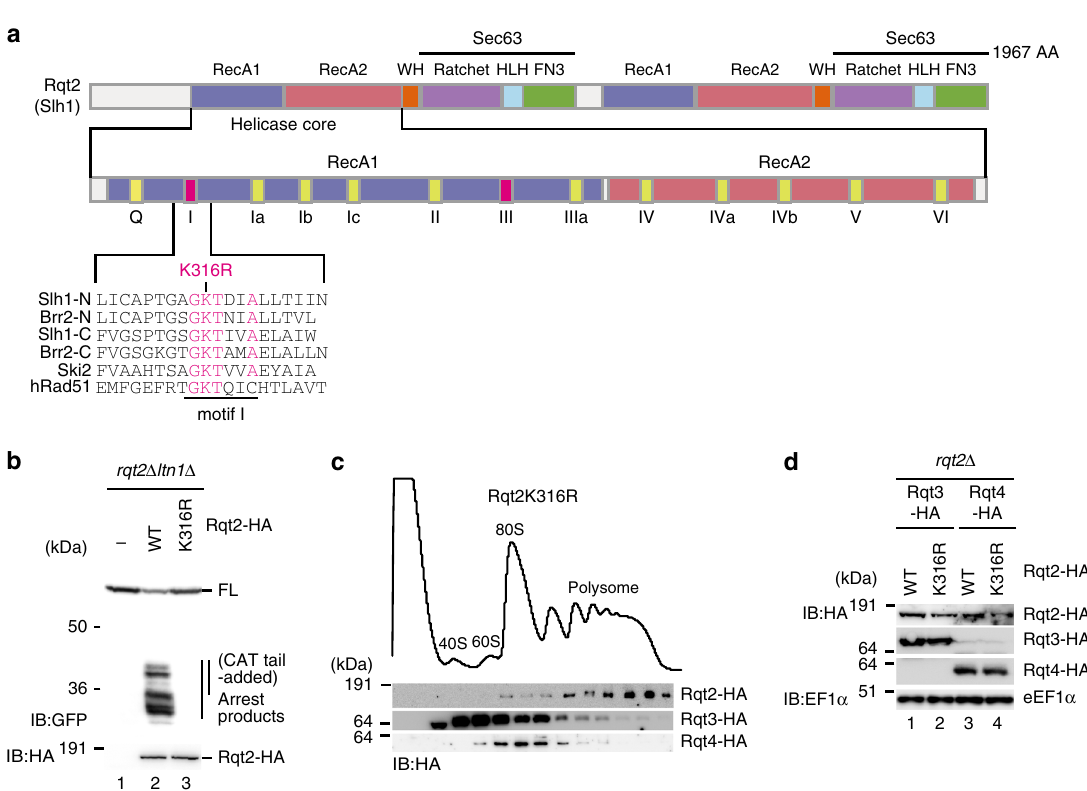
Fig. 4 The mutations of Rqt2 in the conserved residues in ATPase domain diminished RQC. a Alignment of the conserved residues in the RecA1 motif I of Slh1/Rqt2, Brr2, Ski2, and hRad51. The substitution of the lysine to arginine residue of motif I in human Rad51 diminished the ATPase activity 37 . b The mutations of Rqt2 in the conserved residues in ATPase domain diminished RQC. c Rqt2-3 were distributed in heavy polysome fraction in Rqt2K316R mutant. d The expression levels of endogenously HA-tagged Rqt2, Rqt2-K316R, Rqt3, and Rqt4 proteins in Rqt2-K316R mutant